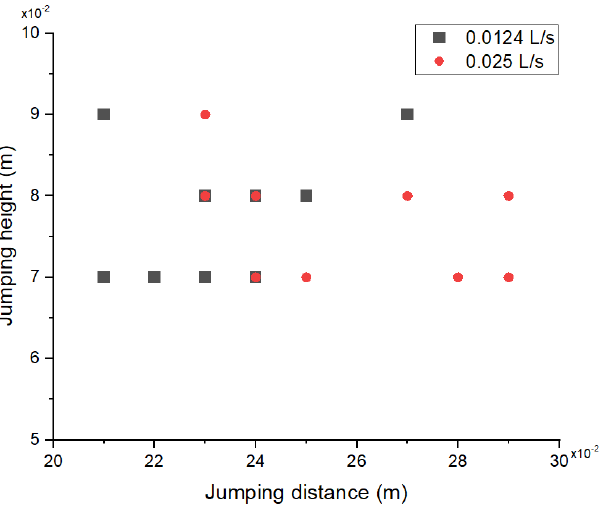
Figure 20. Comparison of jump forces depending on the air injecting speed.